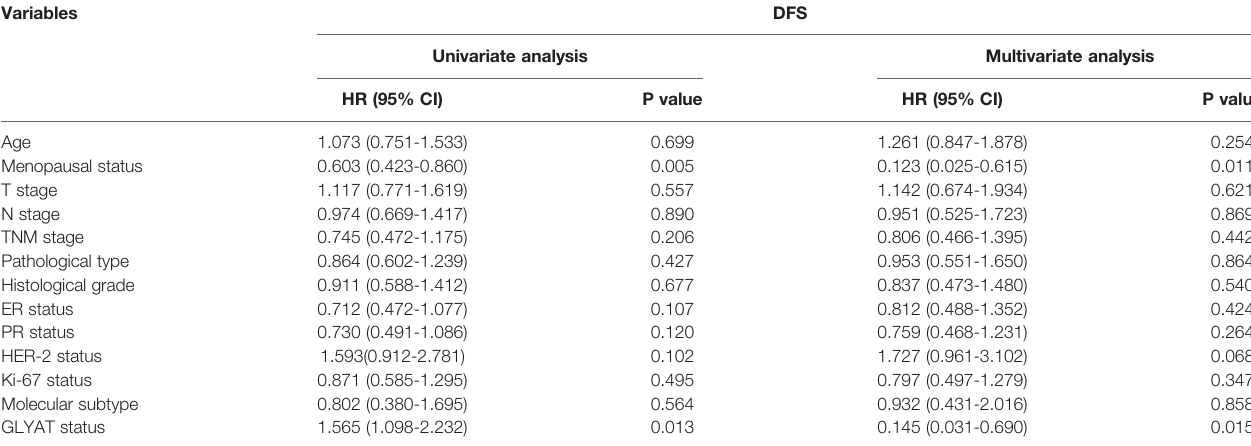
TABLE 2 | Univariate and multivariate analyses of clinicopathological risk factors for disease-free survival among breast cancer